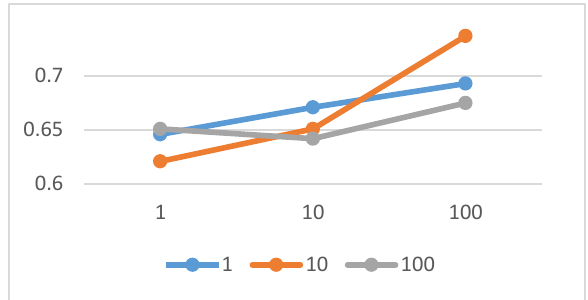
Figure 7. Test of the effect of different values of 17 and 3 on model performance.